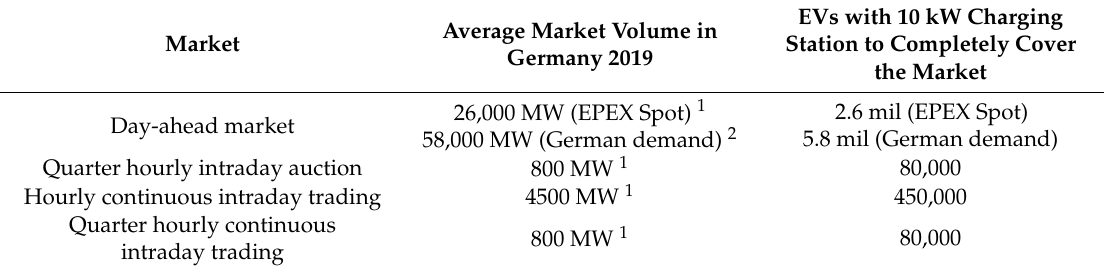
Table 6. Average market volumes and fitting EV quantities for complete covering of considered and relevant German